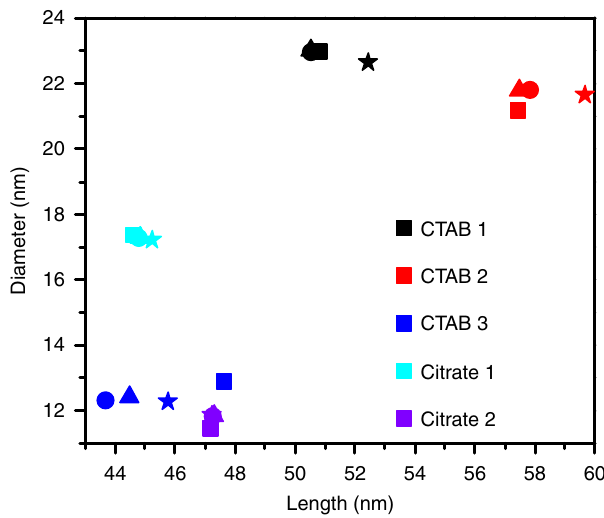
Fig. 8 Median geometrical parameters deduced from MWL-AUC and TEM analysis. Samples are indicated by the given color, symbols correspond to the applied methods: (squares: TEM), (circles: Gans), (triangles: LP) and (stars: